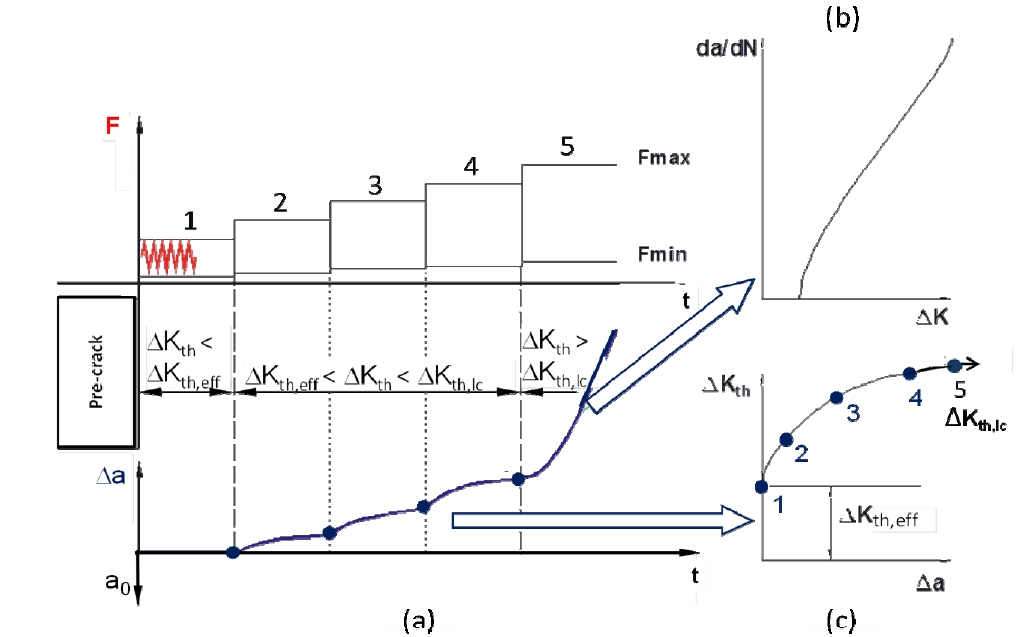
Figure 1: Illustration of the used stepwise increasing constant load amplitude method. The specimens with existing pre-cracks were loaded with a constant amplitude step-by-step. (a) Schematic of the loading procedure. The amplitude was increased to the next step, when the crack stopped to propagate. The final crack extension Δ a and the final stress intensity Δ K are plotted in diagram (c) which characteristics the material resistance against crack propagation (the R-curve). For the last step where stable crack extension occurs, the crack growth rate was measured as a function of Δ K depicted in (b). The load at the start of the stable crack growth corresponds to the long crack threshold value in